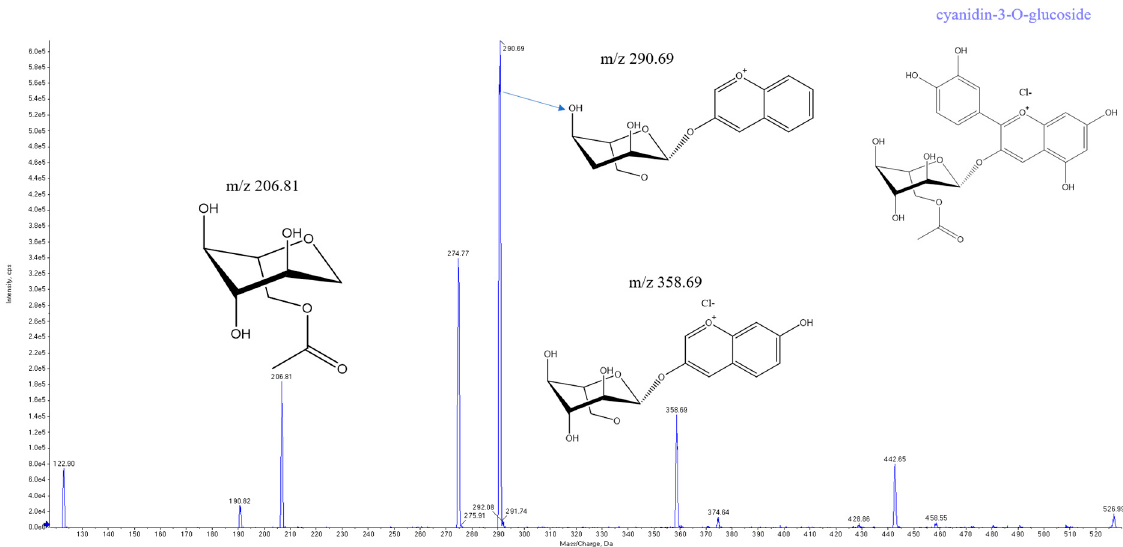
Figure 6. Tandem MS/MS spectrometry for the acetylation product of